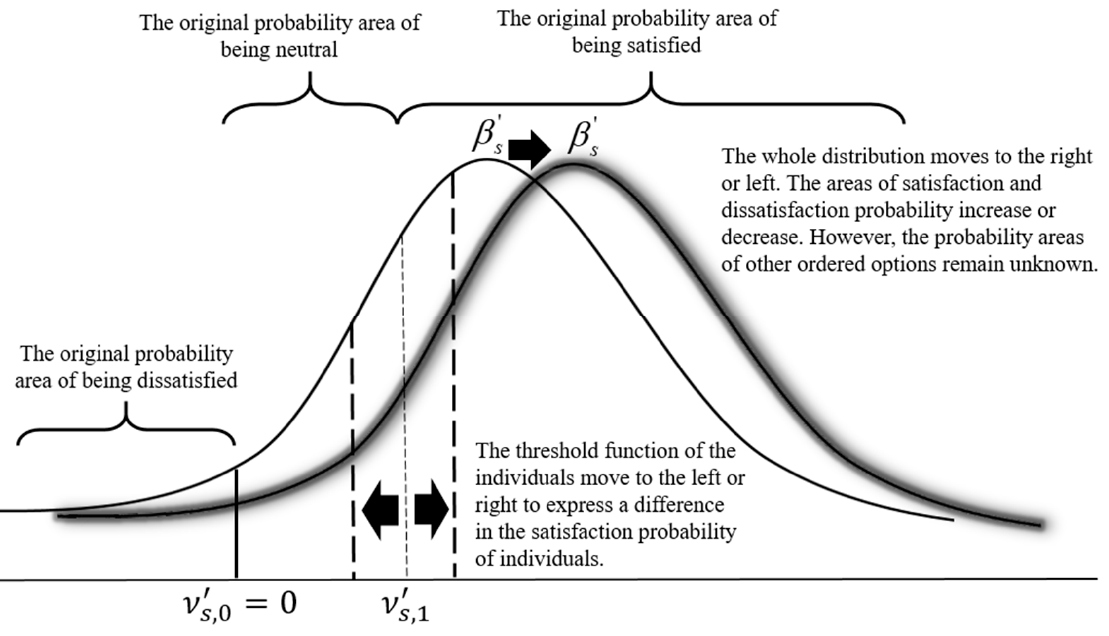
β ' and the thresh- s